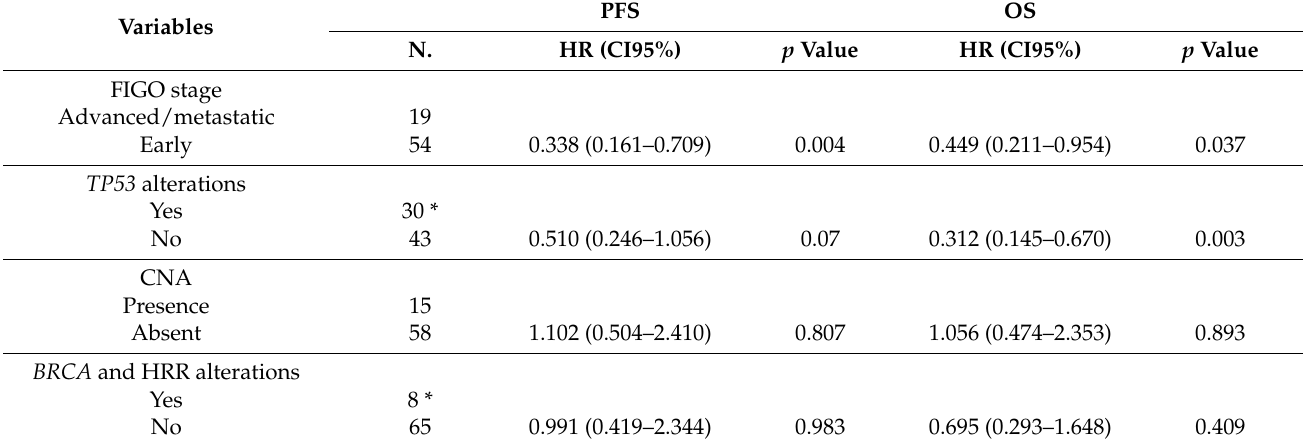
Table 3. Multivariate analysis of clinical outcomes on FIGO disease stage and genomic